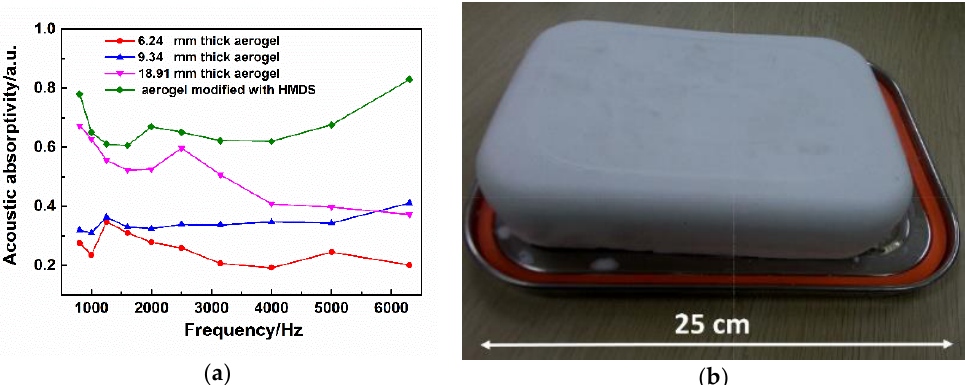
Figure 9. ( a ) Acoustic absorptivity curves of flexible MSQ aerogels measured by standing wave tube method; ( b ) Digital camera image of MSQ aerogel prepared with equal proportions, magnified 200 times.